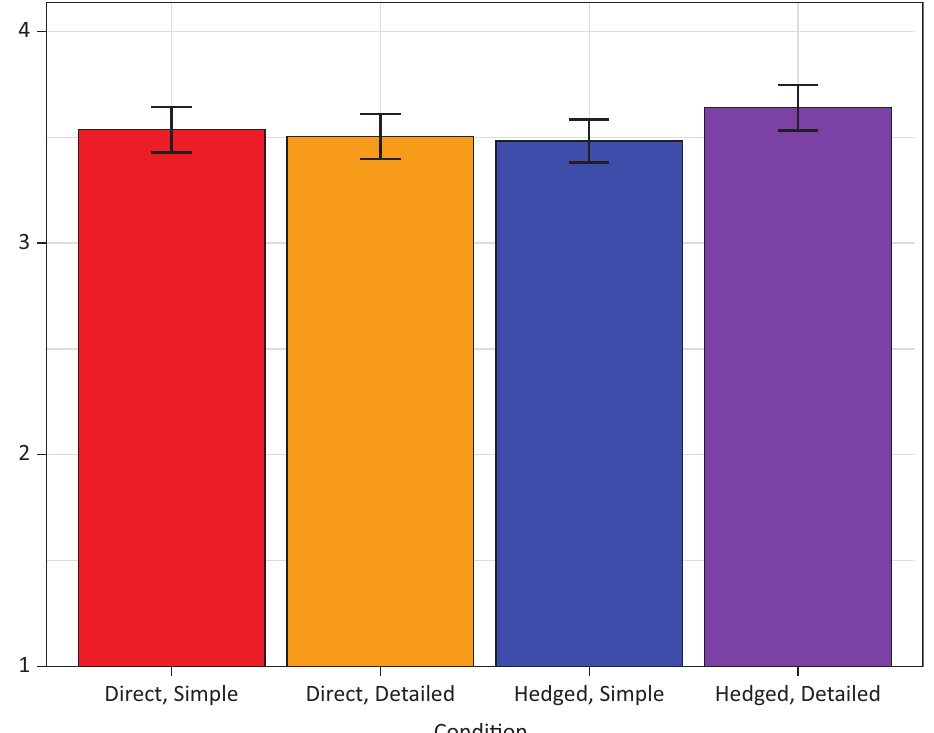
Figure 6. Self-reported belief updating (1–5 Likert-scale) by condition. Notes: N = 1,552. Error bars reflect 95% confidence